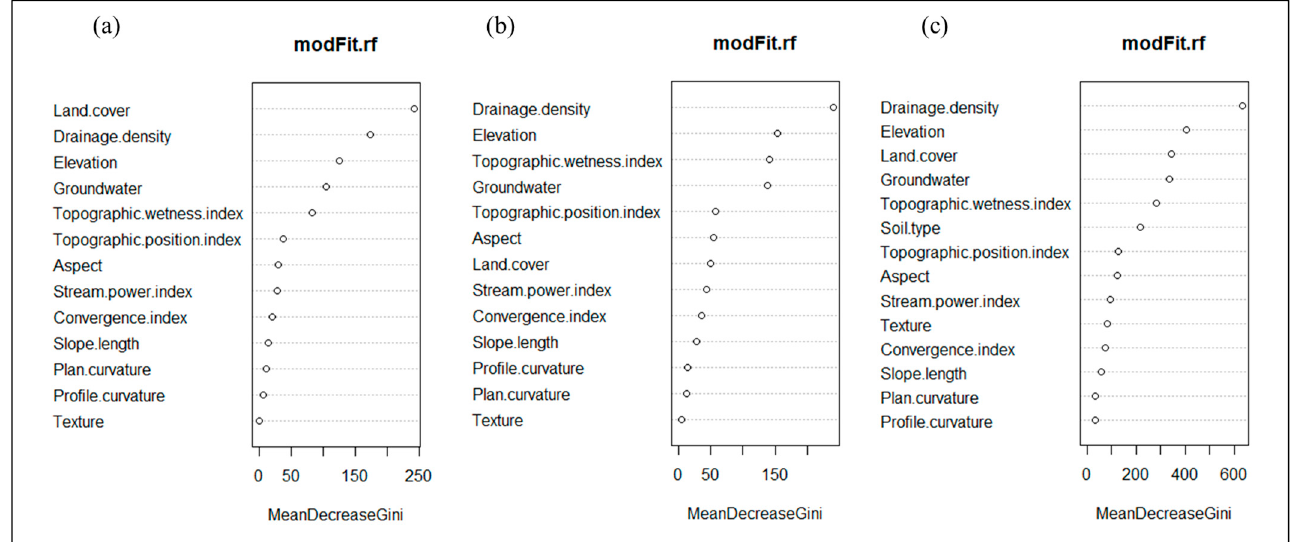
Figure 4. Variable importance plot of gully-erosion predictor factors for ( a ) Nitisol soil type only, ( b ) Vertisol soil type only, and ( c ) all soil types.